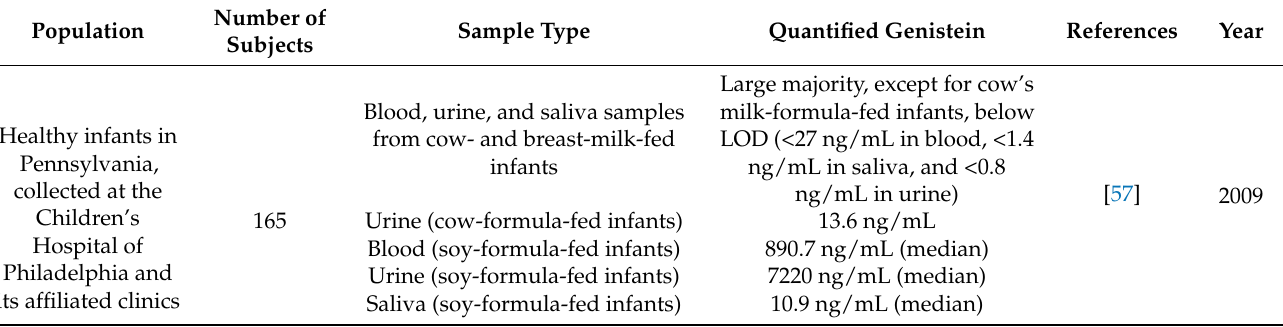
Table 2. Genistein levels in populations